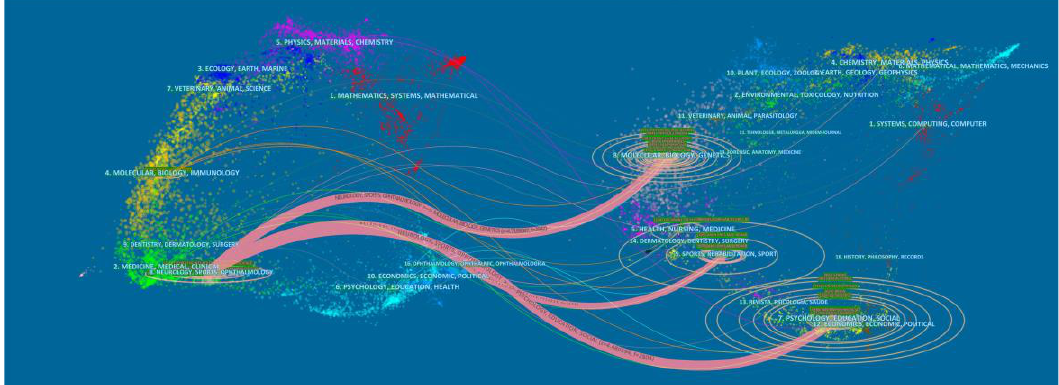
Figure 4. The dual-map overlay of journals in the field of tDCS in stroke.